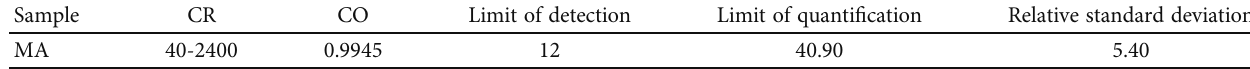
Table 1: Properties of DSPE analysis for